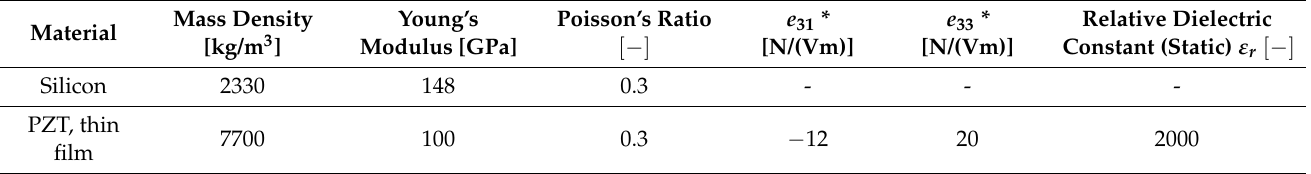
Figure 2. Illustration of the computational model of the piezoelectric transducer. ( a ) 3D view (symbols on the top-left highlight the clamped-in edge), ( b ) Layered cross-section.